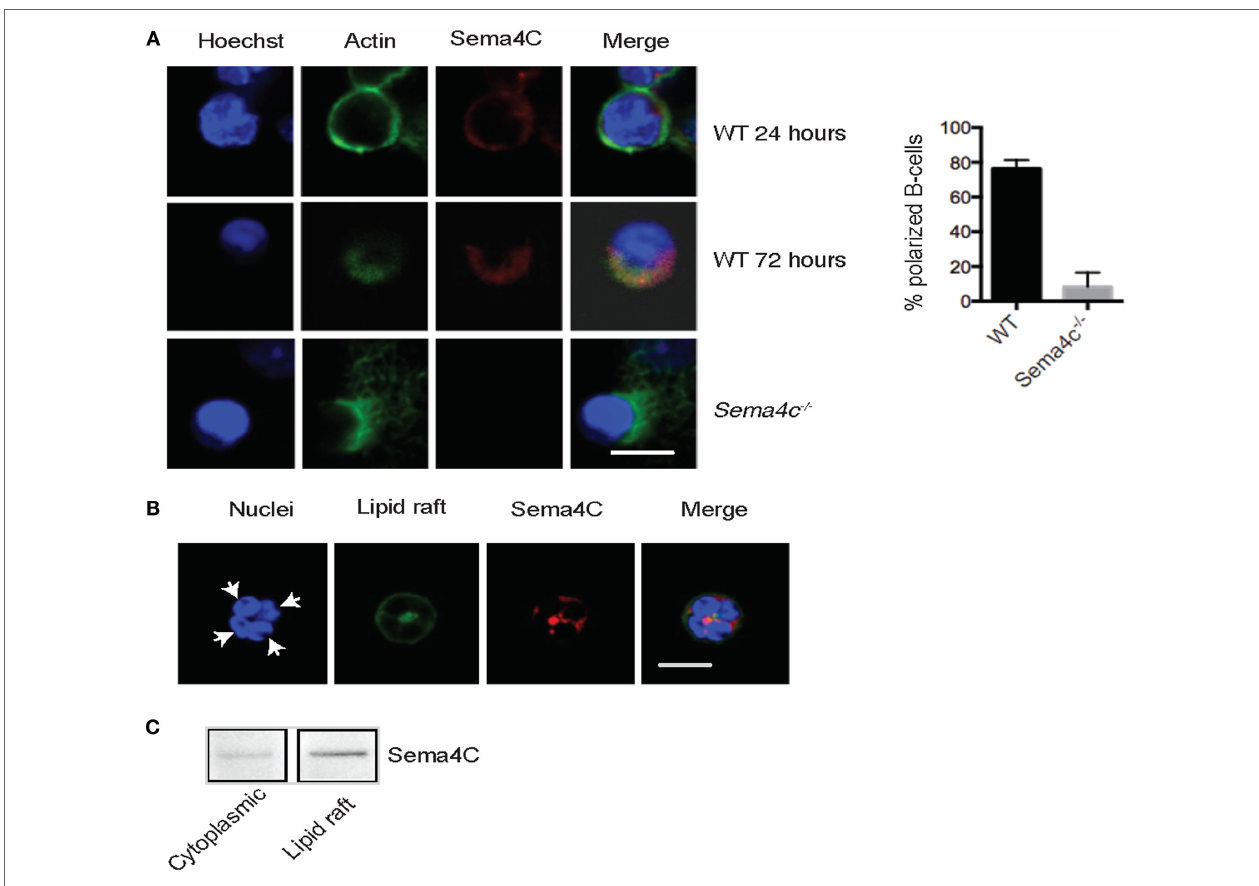
FigUre 4 | Murine sema4c associates with F-actin during B cell maturation . (a) Isolated WT and Sema4C − / − murine splenic B-cells were stimulated with anti-CD40 antibodies, IL-4, and IL-21 in slide chambers and Sema4C (red), F-actin (green), and nuclei (blue) were stained and analyzed by confocal microscopy. Upper panel: 24 h, depicting perimembranous staining of Sema4C and F-actin. Middle panel: WT B-cells, following 72 h of culture, Sema4C and F-actin colocalize toward one pole of the cell. Lower panel: Sema4C − / − following 72 h of culture. No evidence of Sema4C staining and F-actin does not form a normal polar structure. Scale bar: 10 μ m. Histogram: percentage of B-cells expressing a synapse-like structure at one pole after 72 h of expression, comparing WT and Sema4C − / − mice. n = 3 experiments, total cells counted 3–4 fields with 25 cells in total. (B) . Sema4C localizes within lipid rafts. WT B-cells were stimulated with anti-CD40 antibody, in the presence of IL-4 and IL-21. After 72 h, B-cells were double stained with anti-Sema4C antibody (red) and Cholera Toxin B-Alexa Fluor 488 (green). Representative images showing four cells in a cluster with synapse toward the center of the cluster. White arrows indicate one cell, with both the lipid raft fraction and Sema4C located at a pole in the center of the four indicated B-cells. Scale bar: 50 μ m. (c) B-cells stimulated as in (B) were lysed and gradient centrifuged as described in Section “Materials and Methods.” Sema4C was primarily detected in the lipid raft layer (right). Each image represents three independent